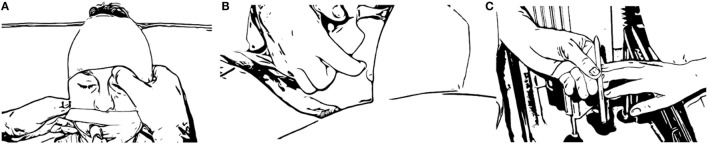
Illustration on how to evaluate the pain response, an integral component of the NWT of unconscious patients unable to obey commands. Apply a steady pressure at the medial aspect of the periorbital rim, at the supraorbital notch (A), or preferably at the angle of the jaw (B). After the pain response has been noted, a peripheral pain stimulus is provided by compressing the fingertips with a pencil (C) and, e.g., a localization, withdrawal, flexion, or extension response can be recorded (52). Based on the response of the patient, the motor component of the Glasgow Coma Scale can then be evaluated. The pupillary response to light and the presence of anisocoria as well as any focal neurological deficits are also noted.